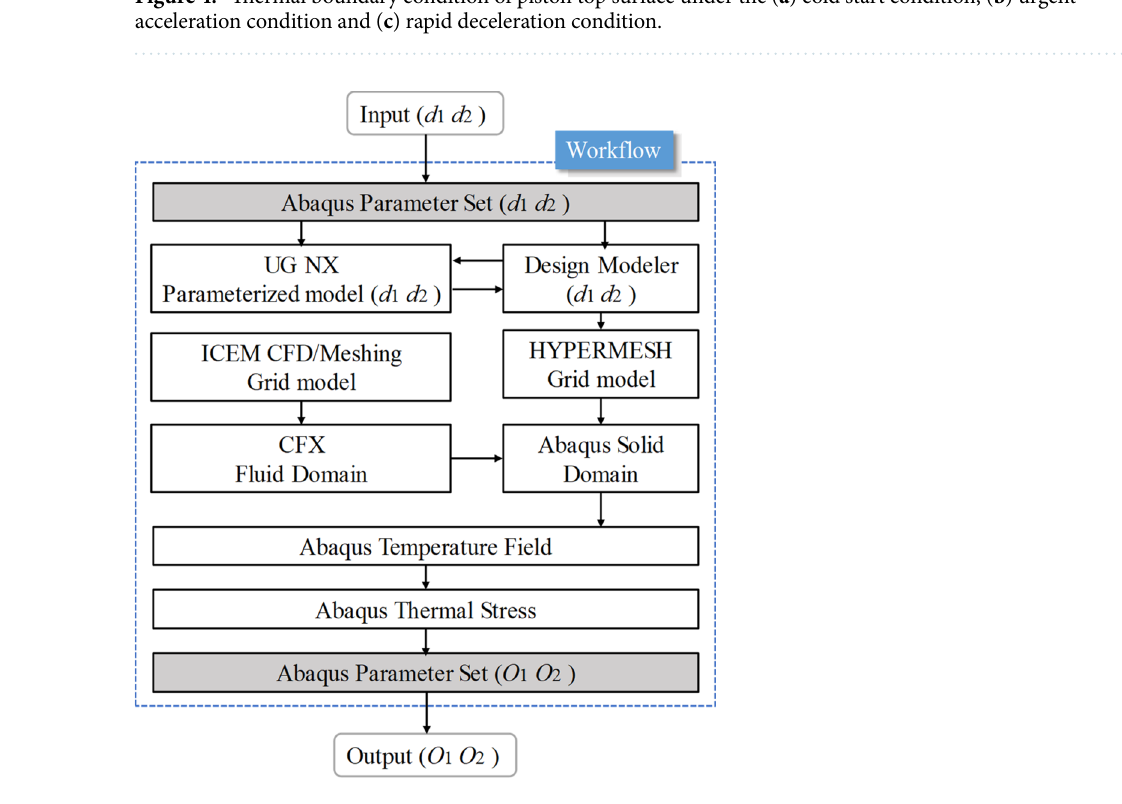
Figure 5. Simulation analysis